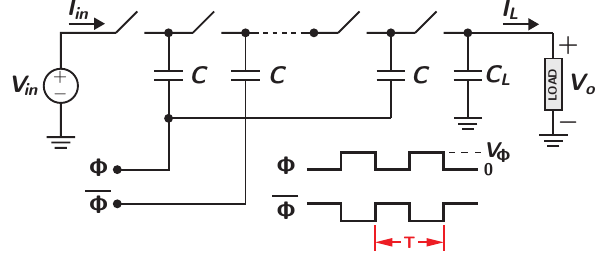
Figure 1. Circuit diagram of N-stage DCP.